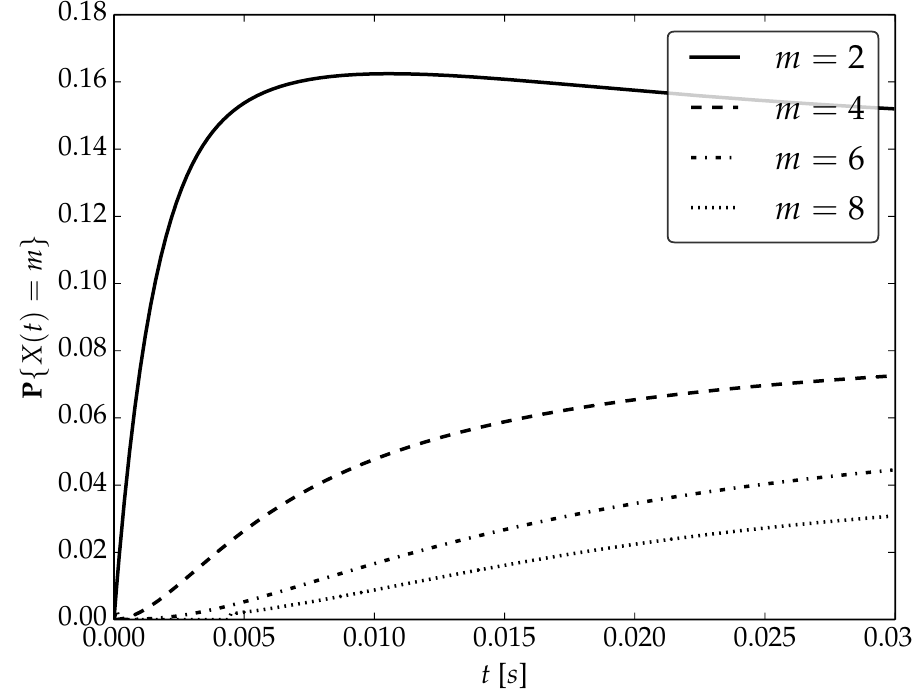
Figure 3. Transient distributions P { X ( t ) = m } for N = 2, batch distribution P 2 and ρ =